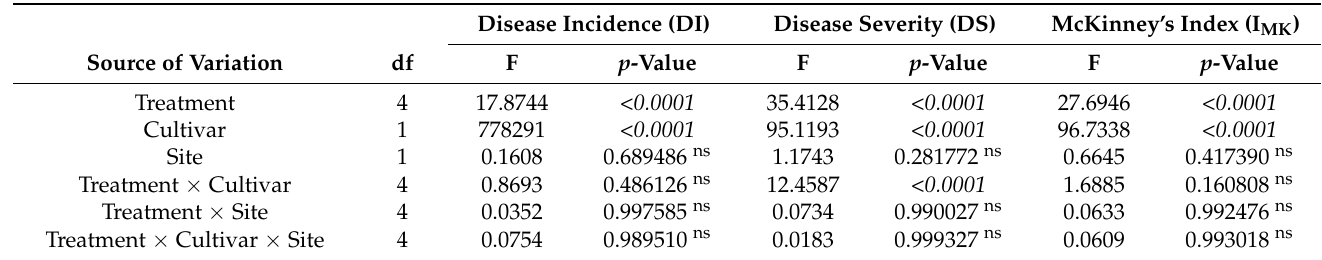
Table 3. Effects of single factors and their interactions in ANOVA on gray mold caused by Botrytis cinerea on wine grape. Disease Incidence (DI) Disease Severity (DS)